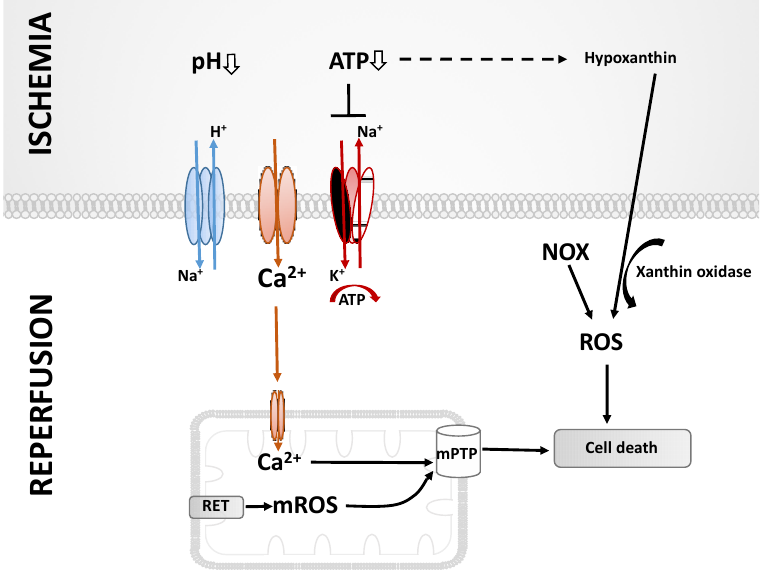
Figure 1. Molecular events leading to ischemia and reperfusion injury (for details see text). ATP: adenosine triphosphate, ROS: reactive oxygen species, mROS: mitochondrial reactive oxygen species,